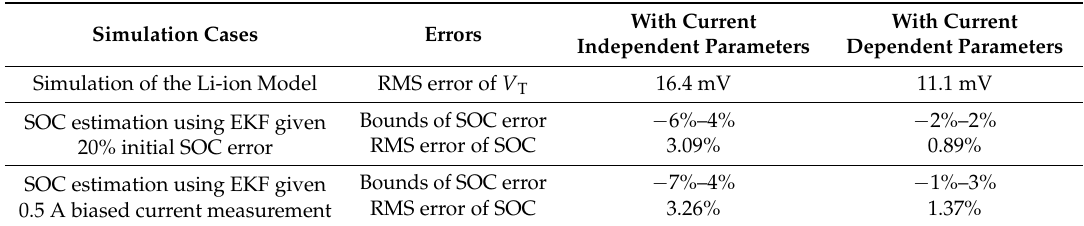
Table 2. Summary of improvements by using current dependent